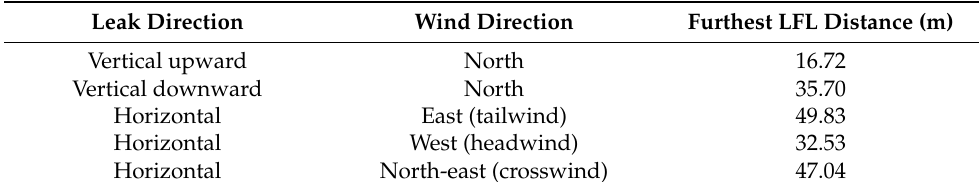
Table 2. LFL distance of leaks.